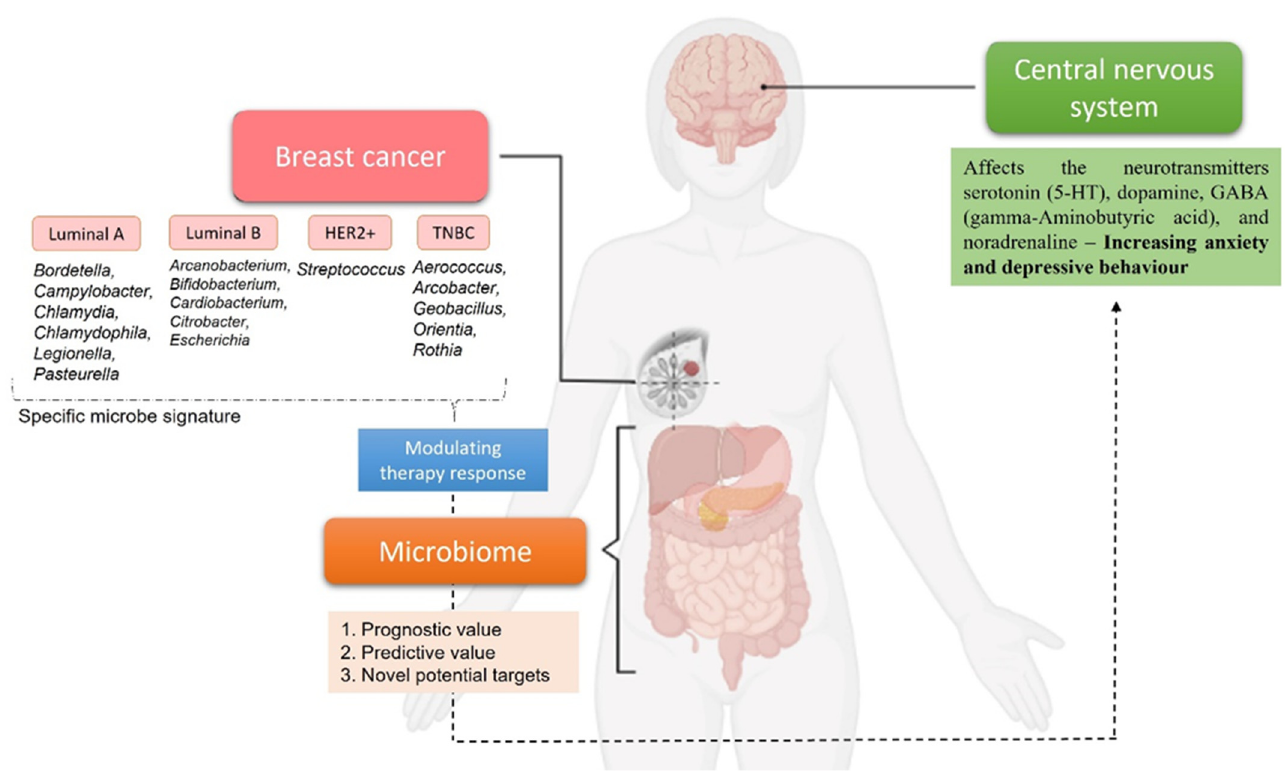
Figure 1. Example of distinct microbial signatures demonstrated by Banerjee et al. that can be associated with different breast cancer subtypes [72]. Once a definite breast cancer microbiome profile is defined, each signature will have a prognostic/predictive value or can be use as potential target to modulate therapy response. The relationship between the microbiome with breast cancer and the central nervous system highlights the importance of these systems for optimal cancer treatment.